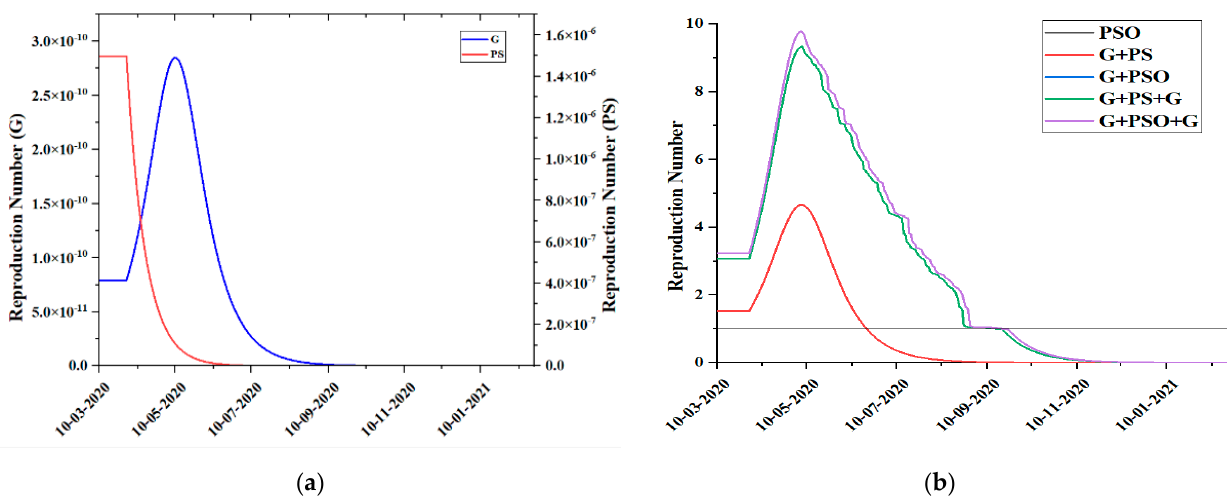
Figure 7. Dynamic behavior of reproduction number ( a ) G and PS ( b ) PSO, G + PS, G + PSO, G + PS + G and G + PSO + G. Table 3. Forecasting of COVID-19 outbreak.